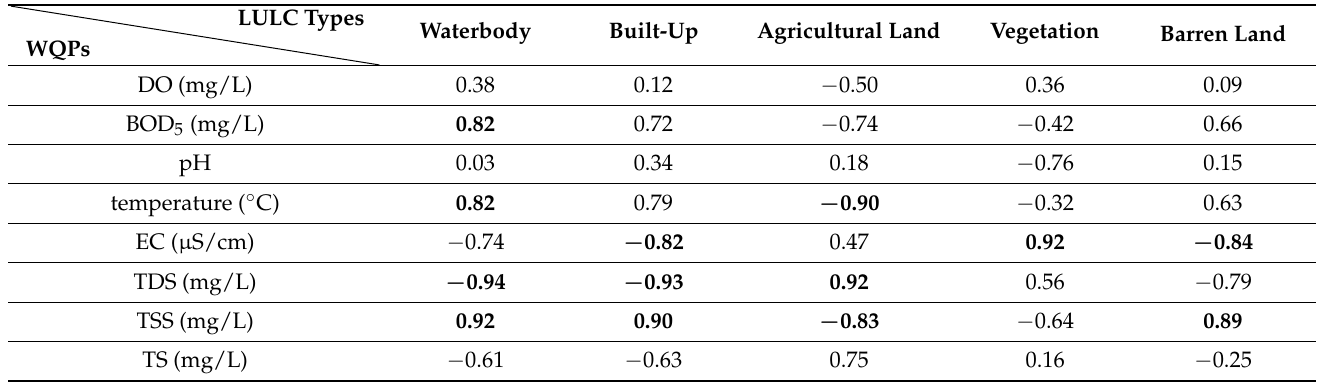
Table 7. Linear relationship (Pearson correlation, r) between WQPs and LULC